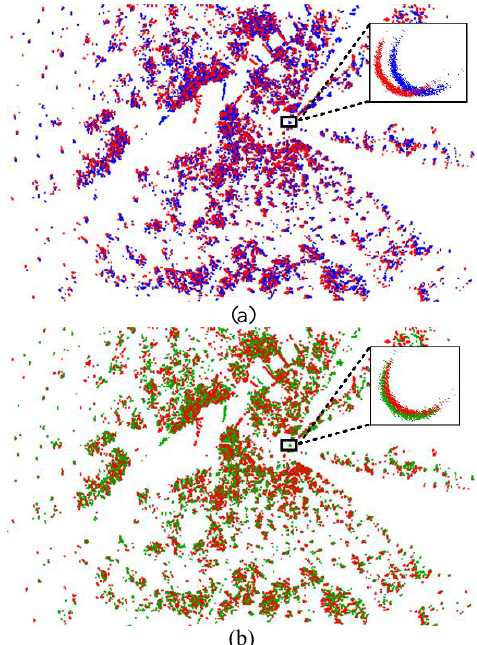
Figure 4. Scan matching results (red points are references, blue points in (a) and green points in (b) are the matched points). 3.3 Forest plot mapping To verify the effectiveness of the proposed method, we achieved forest plots mapping and recovered the trajectory of the BLS system based on the acquired data (Figure 5).